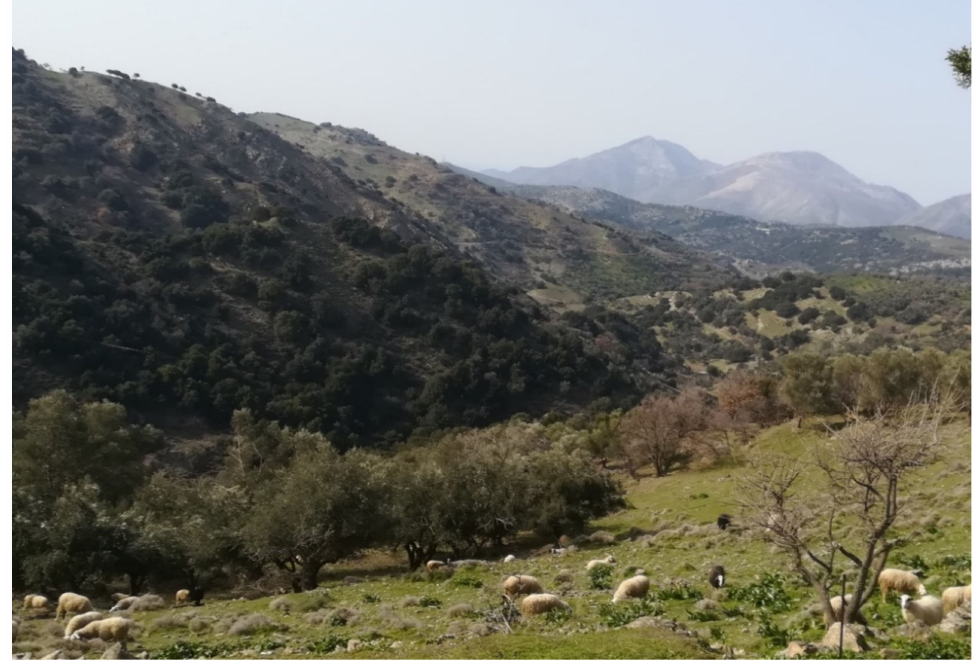
Figure 3. The pastoralist-driven landscape in the rural area of